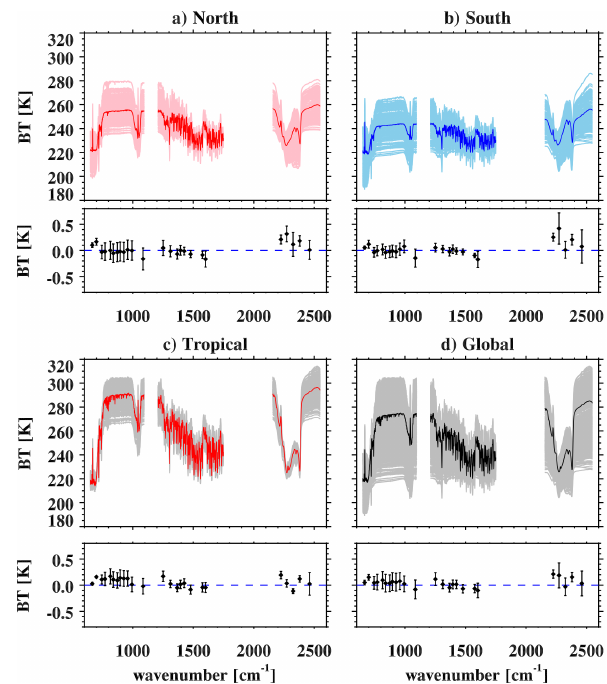
Figure 13. CrIS spectral distribution for CrIS–AIRS SNOs and their mean BT differences with the standard deviation along the 25 spec- tral regions, including (a) north SNOs, (b) south SNOs, (c) tropi- cal SNOs, and (d) the global data set that combines three data sets together. The solid lines represent the average spectrum from the